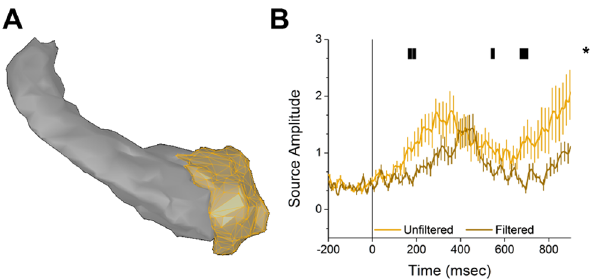
Figure 3. Unfiltered faces evoke significantly larger amygdala responses than filtered faces. A. 3d surface model of the amygdala and hippocampus of a representative subject (amygdala vertices shown in orange). B. Timecourse of amygdala responses evoked by the unfiltered (light orange) and filtered (dark orange) faces. Lines represent the mean 6 SEM. (*= p , 0.05).